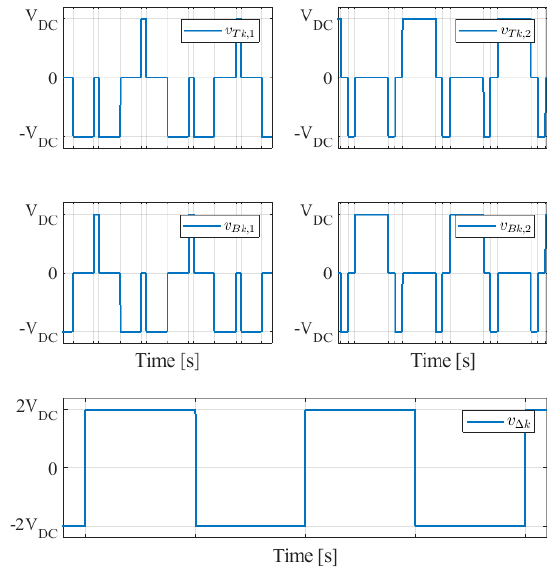
Figure 4. Ideal switching waveforms of a single phase for a two modules MMC.